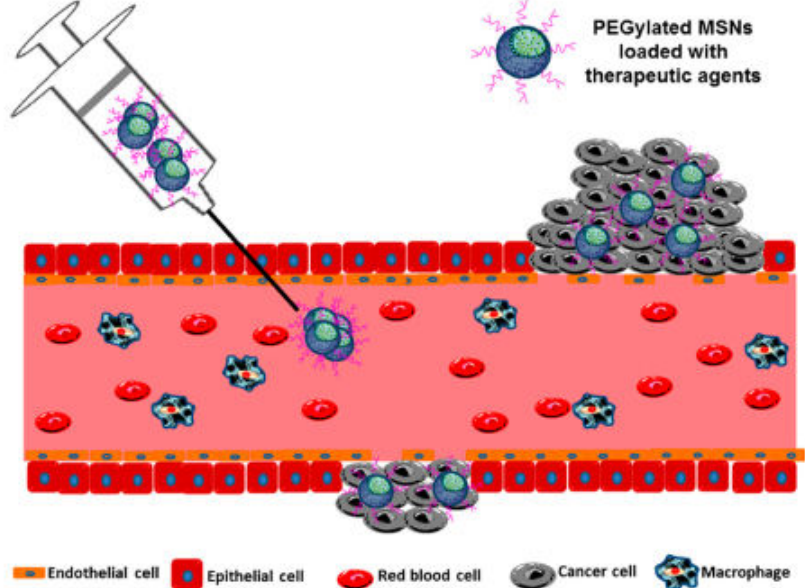
Figure 3. The Enhanced Permeability and Retention (EPR) e ff ect. Nanoparticles passively accumulate in the tumor owing to the presence of fenestration in the tumor blood vessels. Once there, the particles remain in the tissue for long periods of time as a consequence of the poor lymphatic drainage. Reproduced from [110] with permission of MDPI,